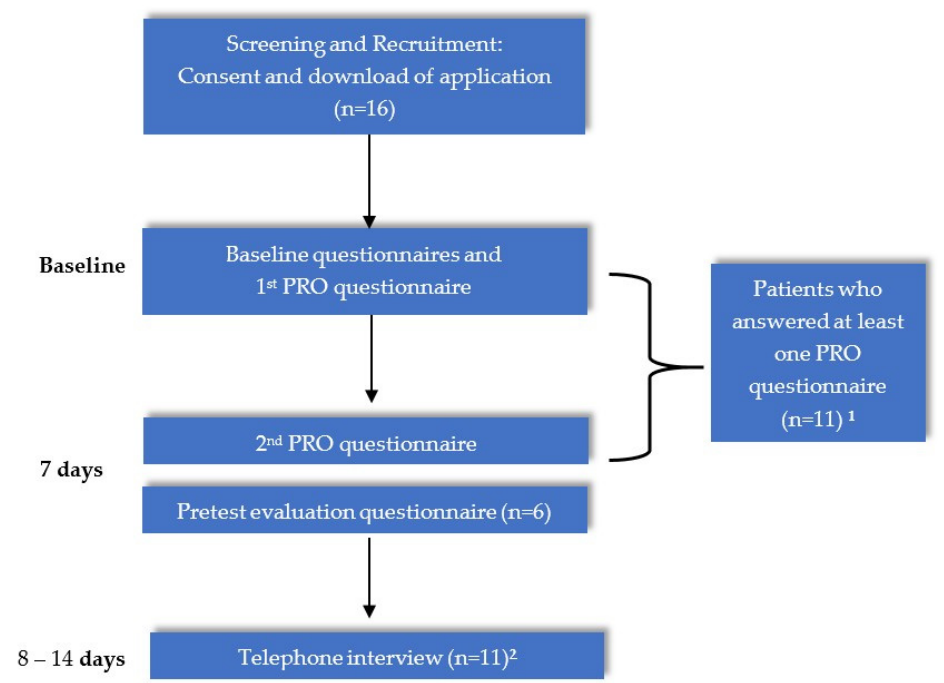
Figure 1. The pretest study flow. 1 Six out of eleven patients answered PRO questionnaires on both occasions; 2 The interview includes one patient who reviewed the questionnaires via e-mail and did not answer in the app.